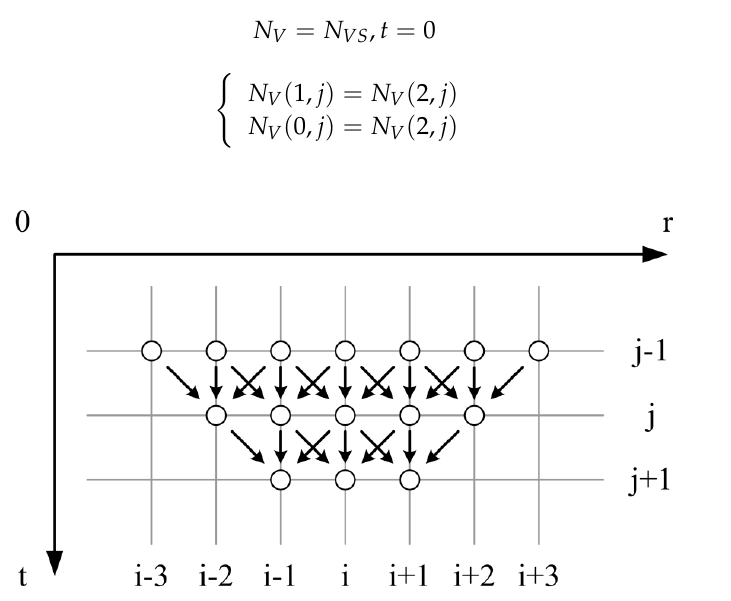
Figure 2. Schematic drawing of the calculation process of oxygen vacancy density in a semiconductor grain during the cooling process.